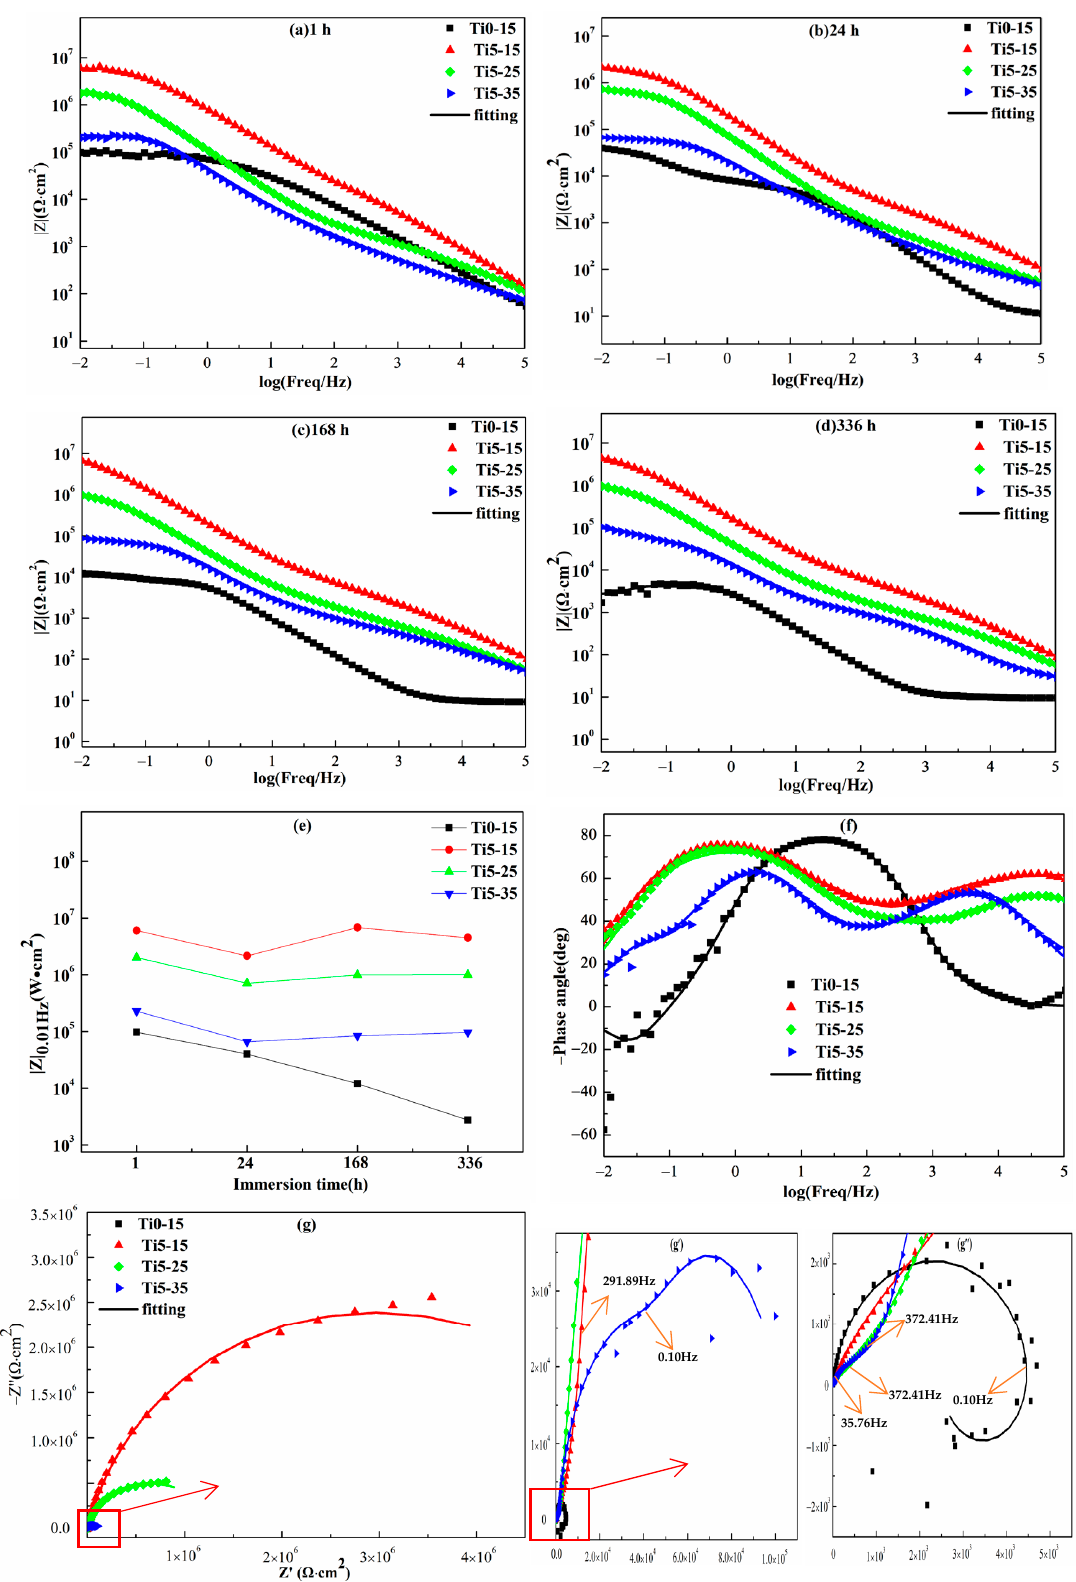
Figure 9. Bode impedance ( e ) of different MAO coatings treated in 3.5% sodium chloride corrosive medium after ( a ) 1 h, ( b ) 24 h, ( c ) 168 h and ( d ) 336 h. ( e ) |Z|0.01 Hz values of Ti0-15, Ti5-15, Ti5-25 and Ti5-35 after soaking. ( f ) Phase diagram, ( g – g ”) Nyquist diagram of Ti0-15, Ti5-15, Ti5-25 and Ti5-35 after soaking for 336 h in 3.5% NaCl solution.